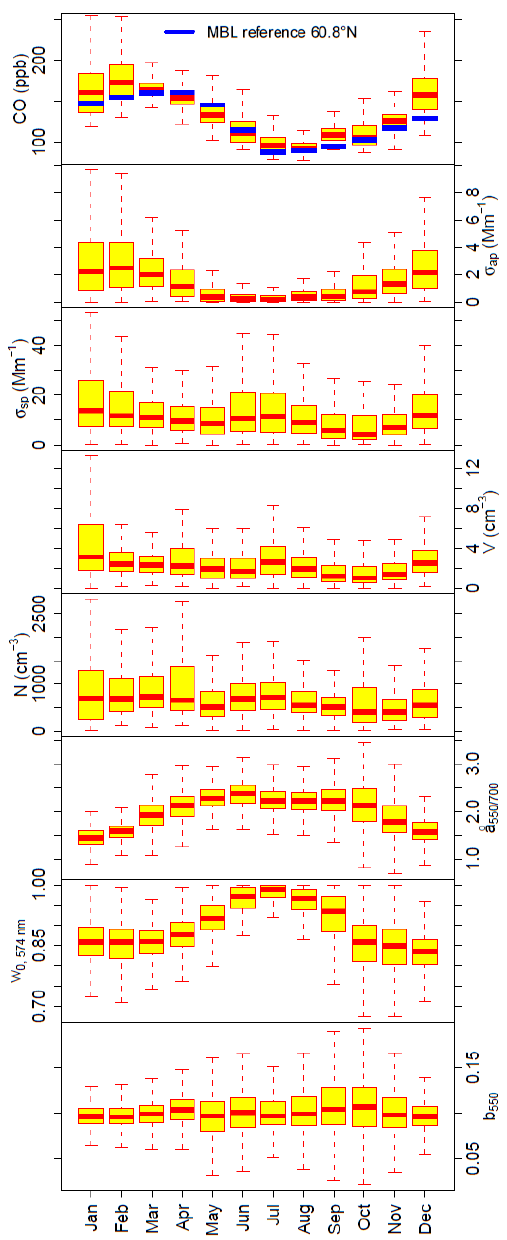
Figure 3 Seasonal variation of hourly average CO mixing ratios, aerosol absorption coefficients, aerosol scattering Fig. 3. Seasonal variation of hourly average CO mixing ratios, coefficients, volume concentration, number concentration, the Ångström exponent (å) for scattering, single scattering albedo (574 nm) and backscattering ratio (550 nm) for 300 m at ZOTTO from October 2006 to December 2011. 5 aerosol absorption coefficients, aerosol scattering coefficients, vol- ume concentration, number concentration, the Ångström exponent ( å ) for scattering, single scattering albedo (574nm) and backscat- 45 tering ratio (550nm) for 300m at ZOTTO from October 2006 to December